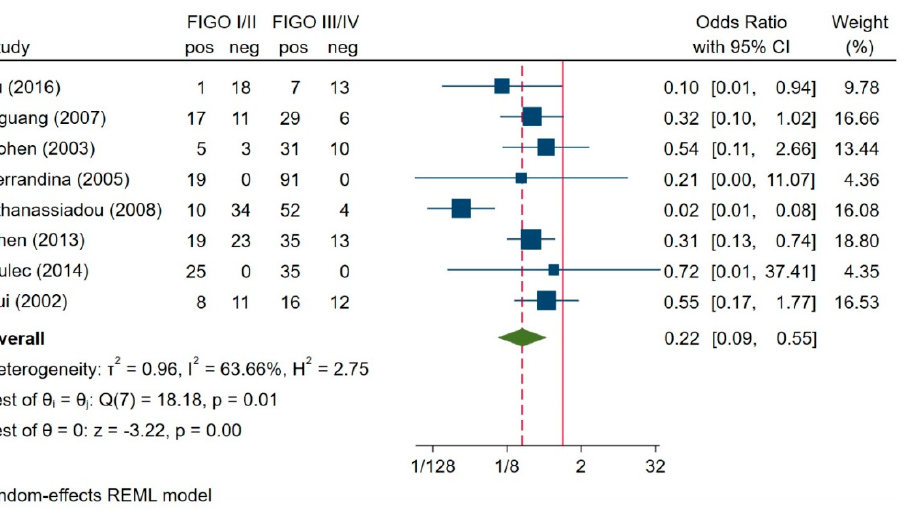
Figure 5. Association between survivin expression and FIGO stage [7,21,22,24,28,34,37,38]. Abbreviations: REML = The Restricted Maximum Likelihood.